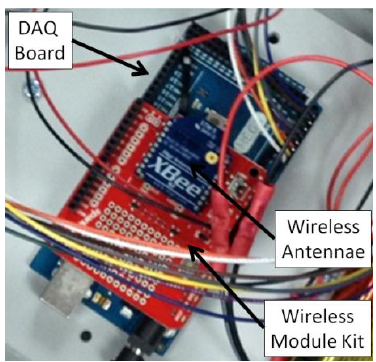
Figure 2. Internal data acquisition and wireless module used for sensor array.